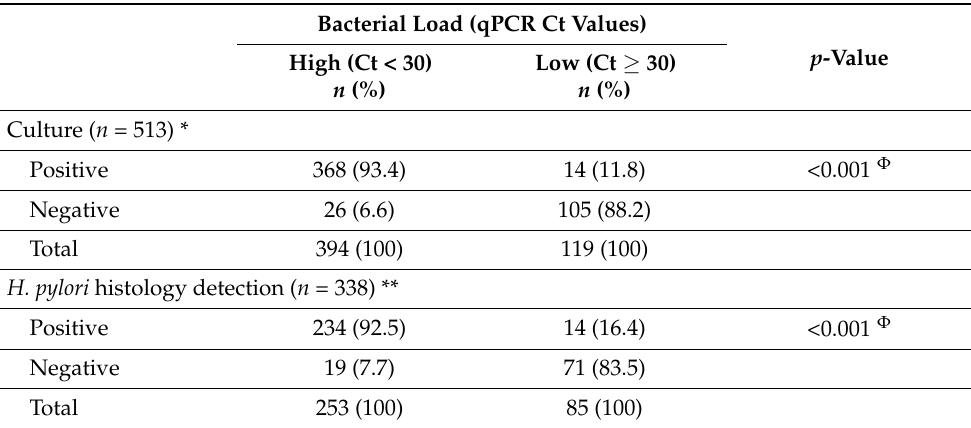
Table 2. Association of bacterial load by qPCR with biopsy culture results ( n = 513) and Helicobacter pylori histology detection ( n = 338, 278 adults and 60